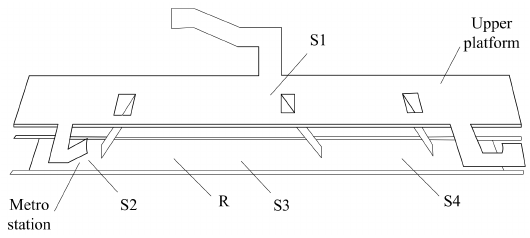
Figure 2. Metro station measuring point